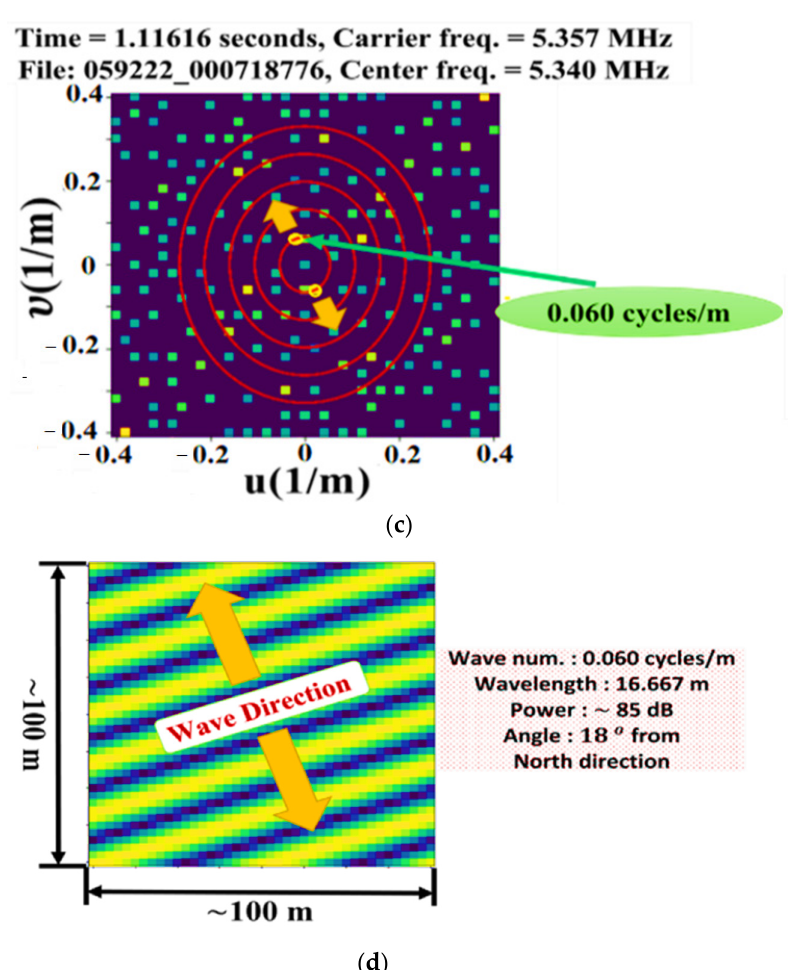
Figure 11. ( a ) A Fourier image of LWA − SV that shows many peaks which represent sets of detected waves. The the strongest (yellow circle) has 0.06 cycles/m, and the wavevector (yellow arrows) pointing north–south. ( b ) The inverse Fourier transform (IFT) of ( a ) revealing the north–south waves. ( c ) A similar set of waves pointing north–south tilt in a westward direction. ( d ) The IFT of ( c ) revealing the tilted waves.